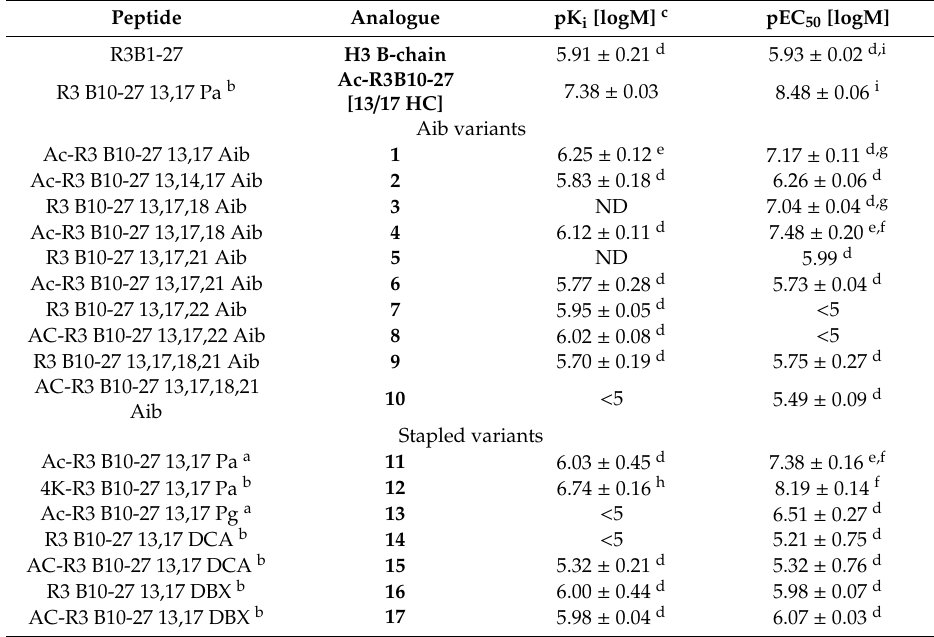
Table 2. E ff ect of helical promoting residue and stapling introduction on a ffi nity and potency at RXFP3.